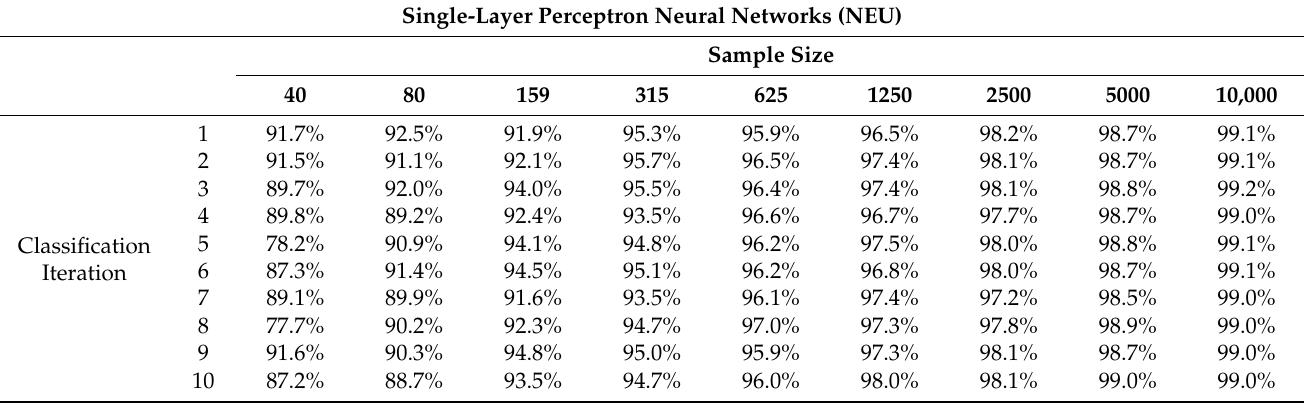
Table A4. Overall Accuracies of Single-Layer Perceptron Neural Networks (NEU)